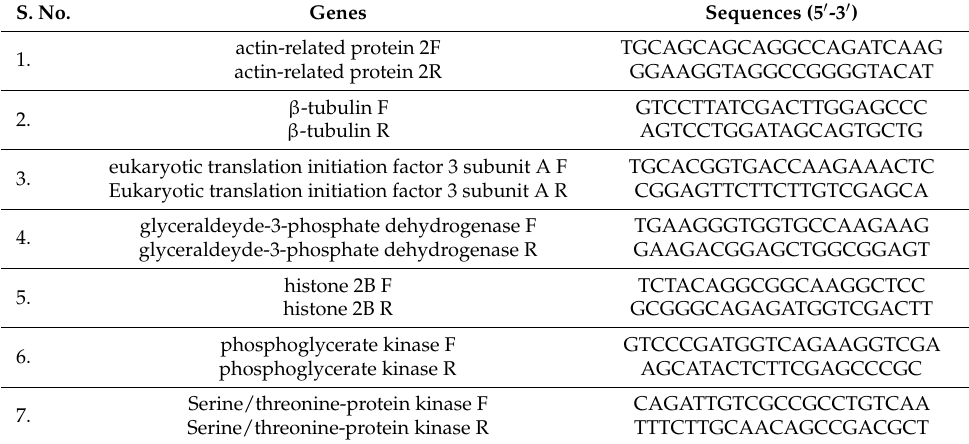
Table 1. List of genes and primers used for multilocus sequence typing in Tilletia indica . S. No. Genes Sequences (5 (cid:48) -3 (cid:48)